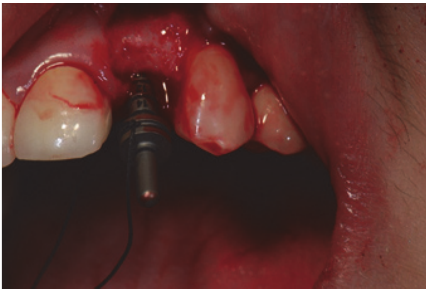
Figure 4: Placement of a paralleling pin to check angulation of the